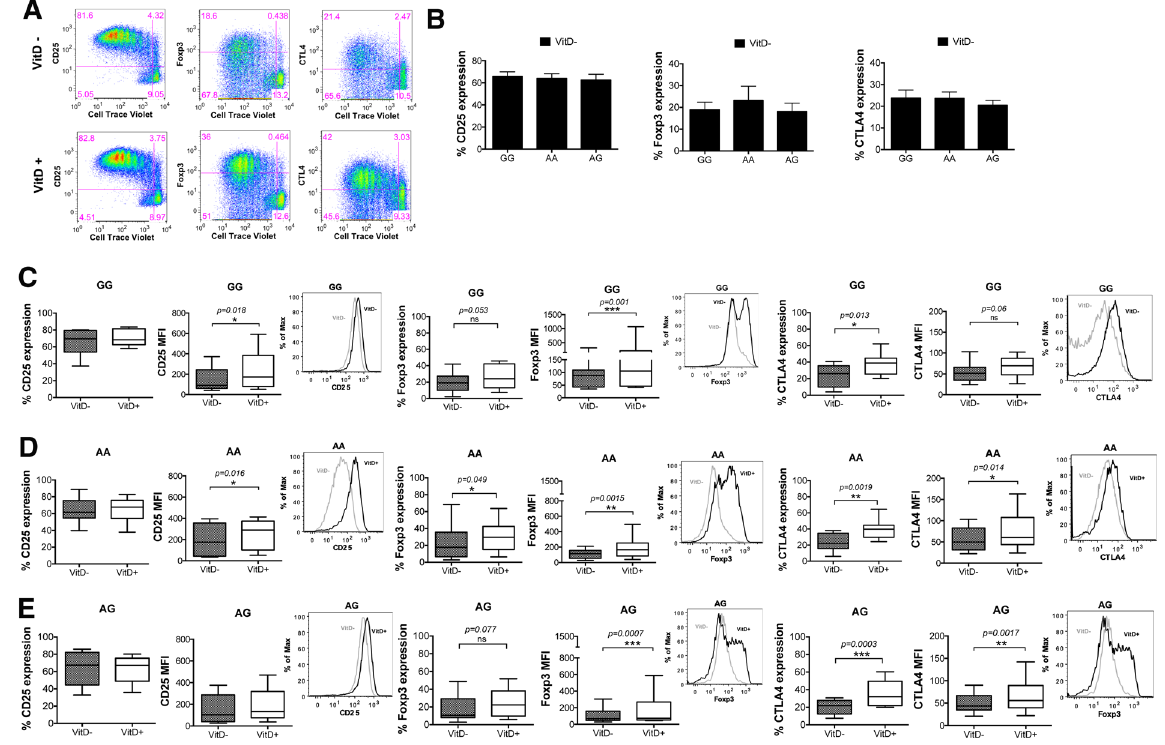
Figure 5. AA, AG and GG individuals express similar levels of CD25, Foxp3 and CTLA-4 molecules. CD4 + CD25 − T cells were activated in vitro with aCD3 antibody and CHO-CD80 cell line in the presence or absence of 1,25(OH) 2 D 3 for 5 days. ( A ) Representative flow cytometry plots showing proliferating T cells expressing CD25, Foxp3 and CTLA-4. ( B ) Percentage of proliferating cells that express CD25, Foxp3